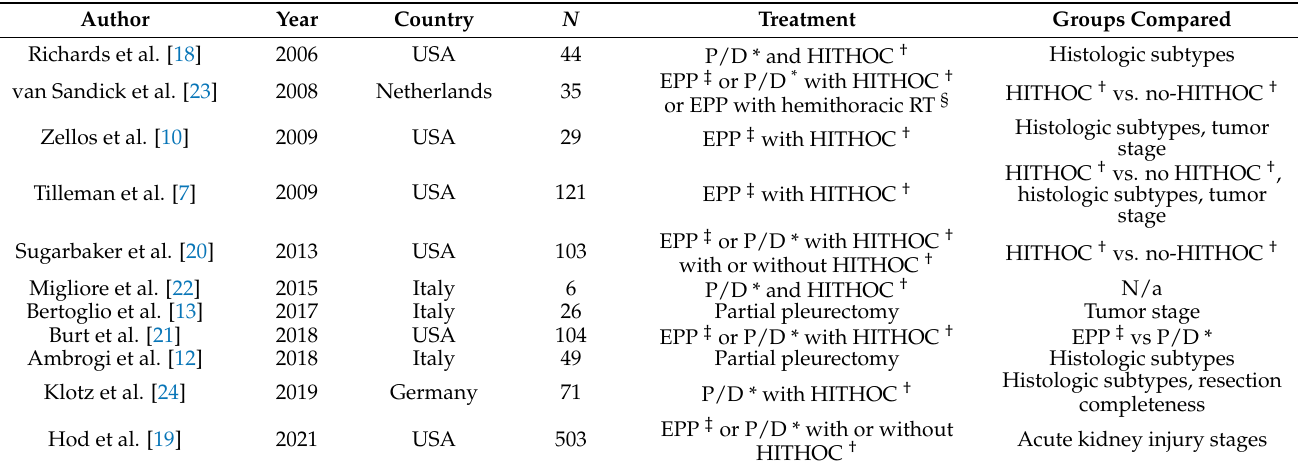
Figure 1. Flow chart of database search and literature selection, as per Preferred Reporting Items for Systematic Reviews and Meta-Analyses (PRISMA) guidelines. Table 1. Studies included in the systematic